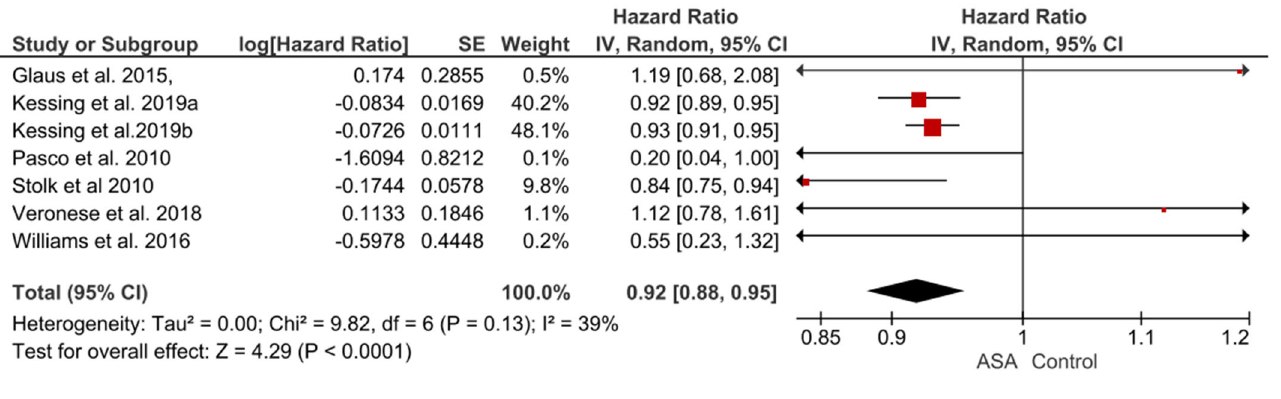
Figure 5. Observational studies on the effect of ASA on the occurrence of mood disorders–the pooled hazard ratio.